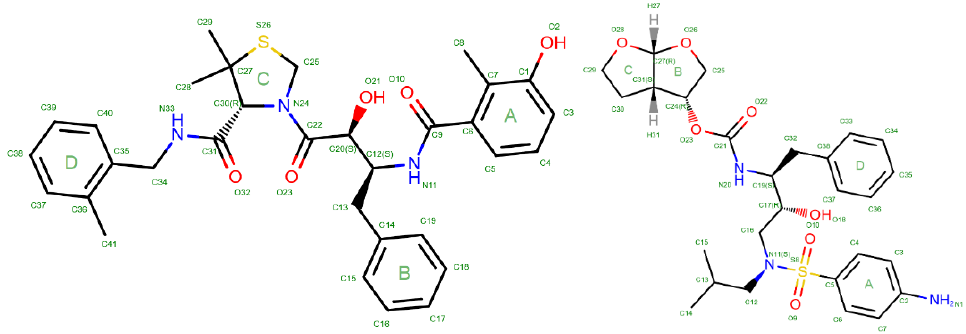
Figure 1. Two-dimensional diagram along with the numbering scheme of JE-2147 ( left ) and darunavir ( right ) molecules according to the RCSB PDB service.